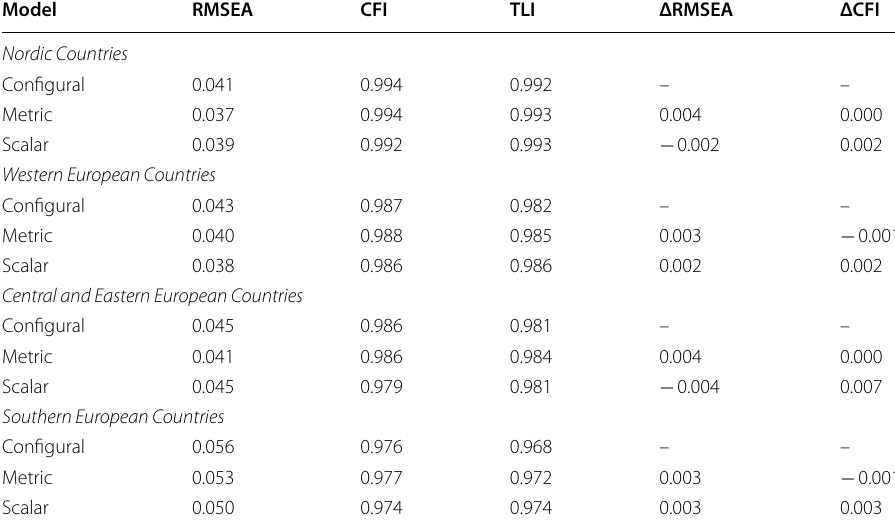
Country clusters-specific